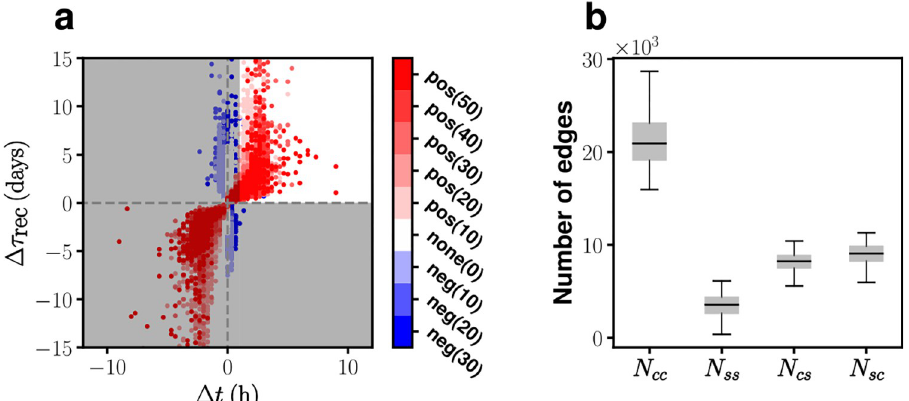
Fig 6. Filtering the pool of network morphologies by imposing constraints on Δ t and Δ τ rec . (a) point locations in the space of Δ t and Δ τ rec , each of which corresponds to a network model listed in Table 1. Different types and levels of indegree-outdegree correlation are color-coded with blue and red. Network models falling into the gray-shaded region were excluded. (b) Numbers of intra-subdivision ( N cc and N ss ) and inter-subdivision ( N cs and N sc ) edges for the group of selected model networks satisfying Δ t > 1 hr and Δ τ rec > 0. (the number of points in the highlighted white area = 1,084; total number of points = 25,140).